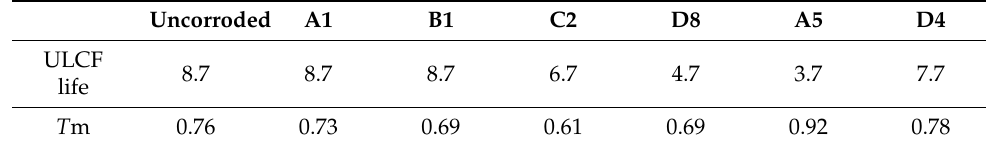
( b ) Figure 13. Distribution of equivalent plastic strain ε p at the weld toe corner of the pier: ( a ) ε p of uncorroded pier; ( b ) ε p of corroded pier A1 when cracked. Table 5 shows the ULCF crack-initiation life obtained by simulation of piers with different corrosion times. The ULCF crack-initiation life for the uncorroded pier is 8.7, which remains unchanged for corroded piers A1 and B1. However, the ULCF crack-initi- ation life of piers C2 and D8 decreases remarkably by about 23% and 46%, respectively. Therefore, the ULCF crack-initiation life of corroded piers declines only slightly when corrosion degradation is not noticeable, so the seismic design of structures need not con- sider corrosion in this case. In addition, the simulation indicates that the ULCF crack-ini-